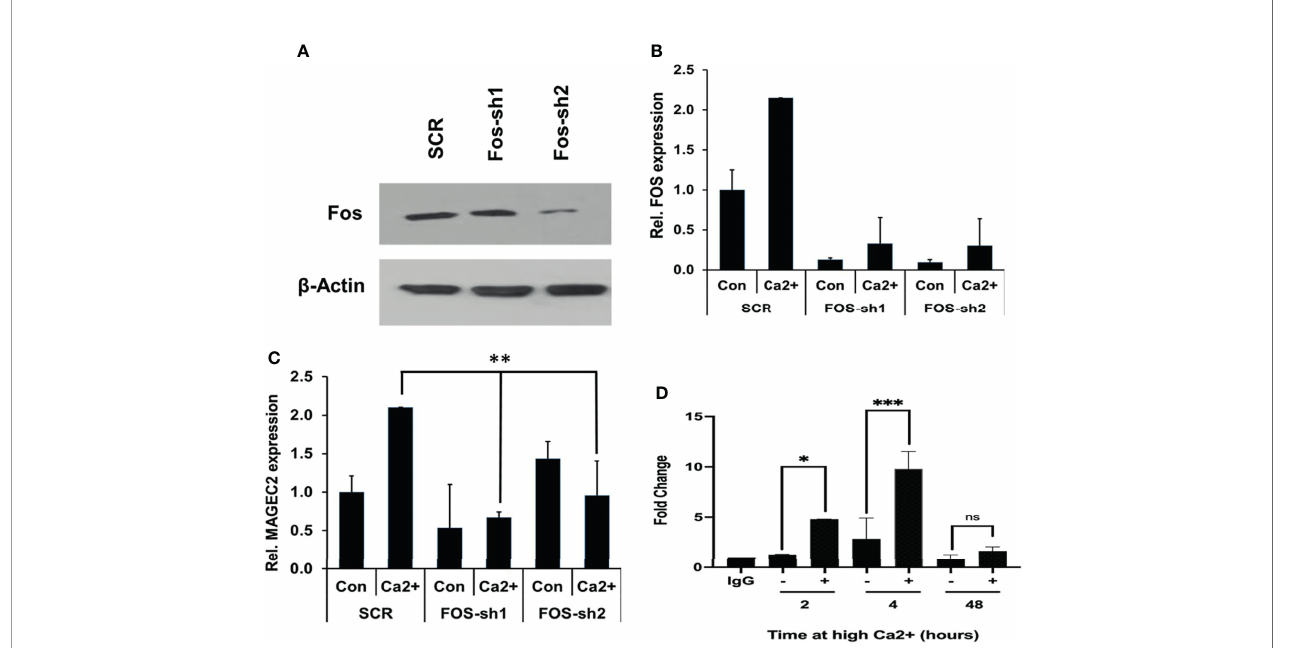
FIGURE 7 | High Ca 2+- induced expression of MAGEC2 is attenuated following downregulation of cFOS. (A) BT-549 cells were transfected with control (SCR) or shRNA plasmids (FOS-sh1 and FOS-sh2) targeting c-FOS. The expression of c-FOS was con fi rmed by western blotting. (B, C) BT-549 cells transfected with control or c-FOS targeting shRNAs were cultured in complete medium without (Con) or with high Ca 2+ (Ca 2+ ) for 48 h. The cells were harvested and the expression of c-FOS (C) and MAGEC2 (D) assessed by RT-PCR. (D) Parental BT-549 cells were grown to 70-80% con fl uency, then treated with or without high Ca2+ for the indicated times. Cells were subsequently cross-linked and processed for ChIP assays as described in materials and methods using antibodies against c-FOS. Puri fi ed DNA fragments were analyzed by real-time PCR and presented as fold change relative to IgG control. Con, complete medium control; Ca 2+ , complete medium supplemented with high Ca 2+ . * denotes p < 0.05, ** denotes p < 0.001, *** denotes p < 0.0001, ns denotes not signi fi